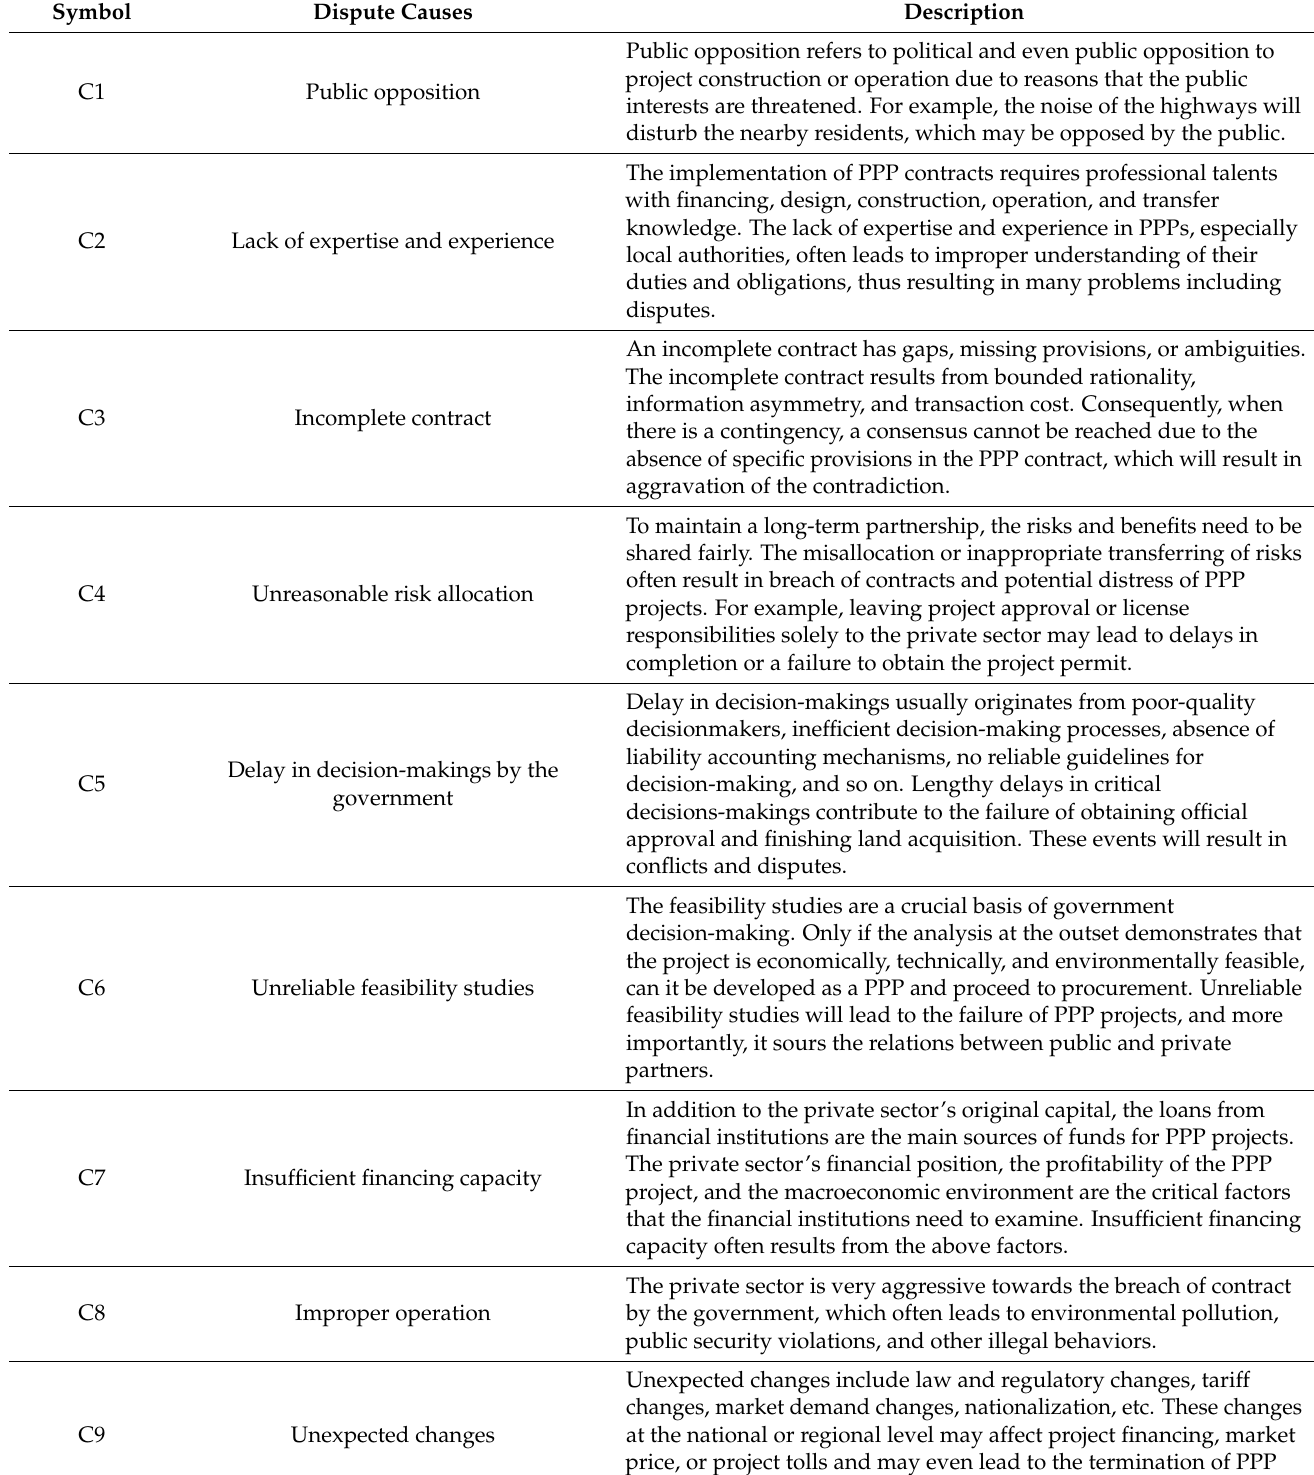
Table 2. The causes of PPP disputes and